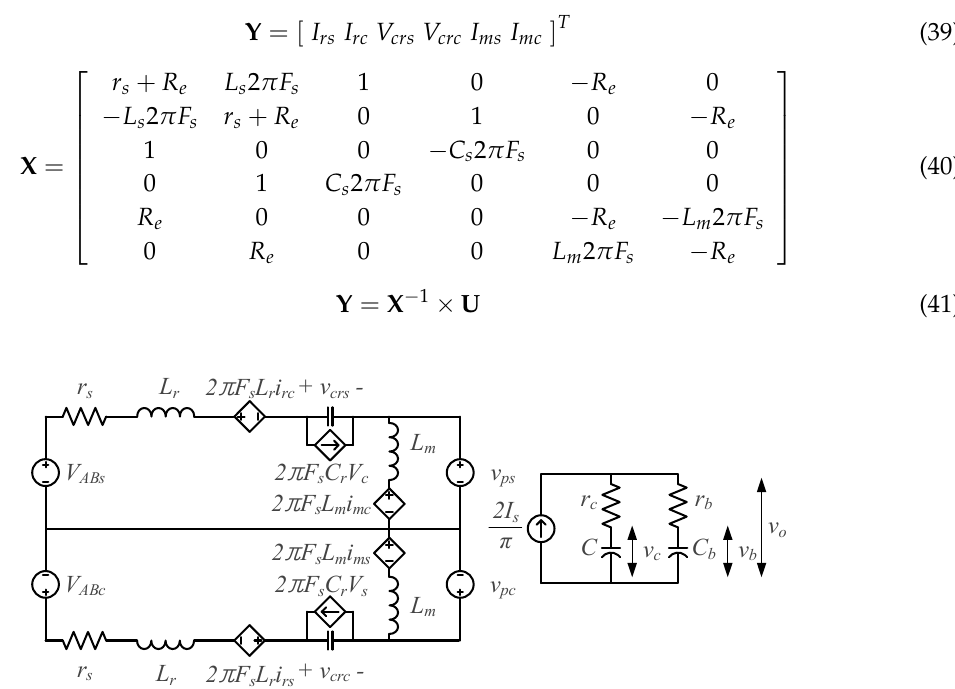
Figure 5 . Large signal model of the LLC resonant converter. Figure 5. Large signal model of the LLC resonant